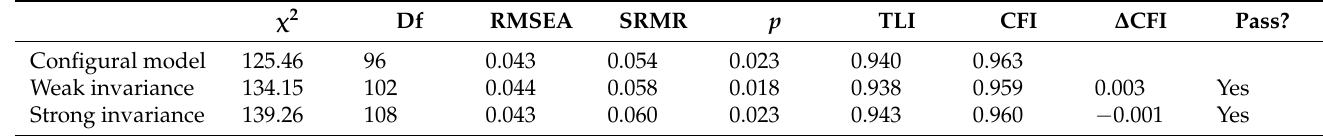
Table 3. Invariance